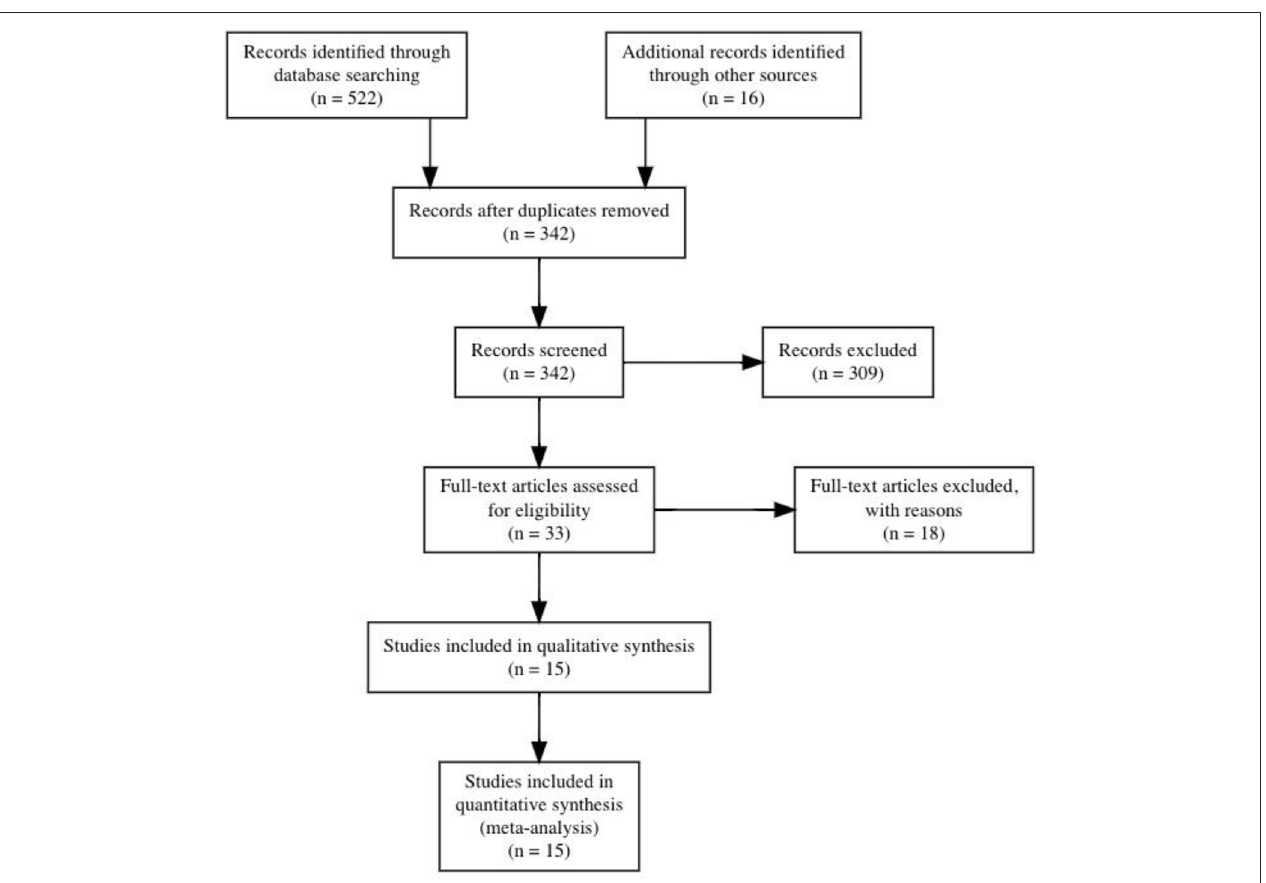
FIGURE 1 | Flow chart illustrating the different stages of search and study selection.